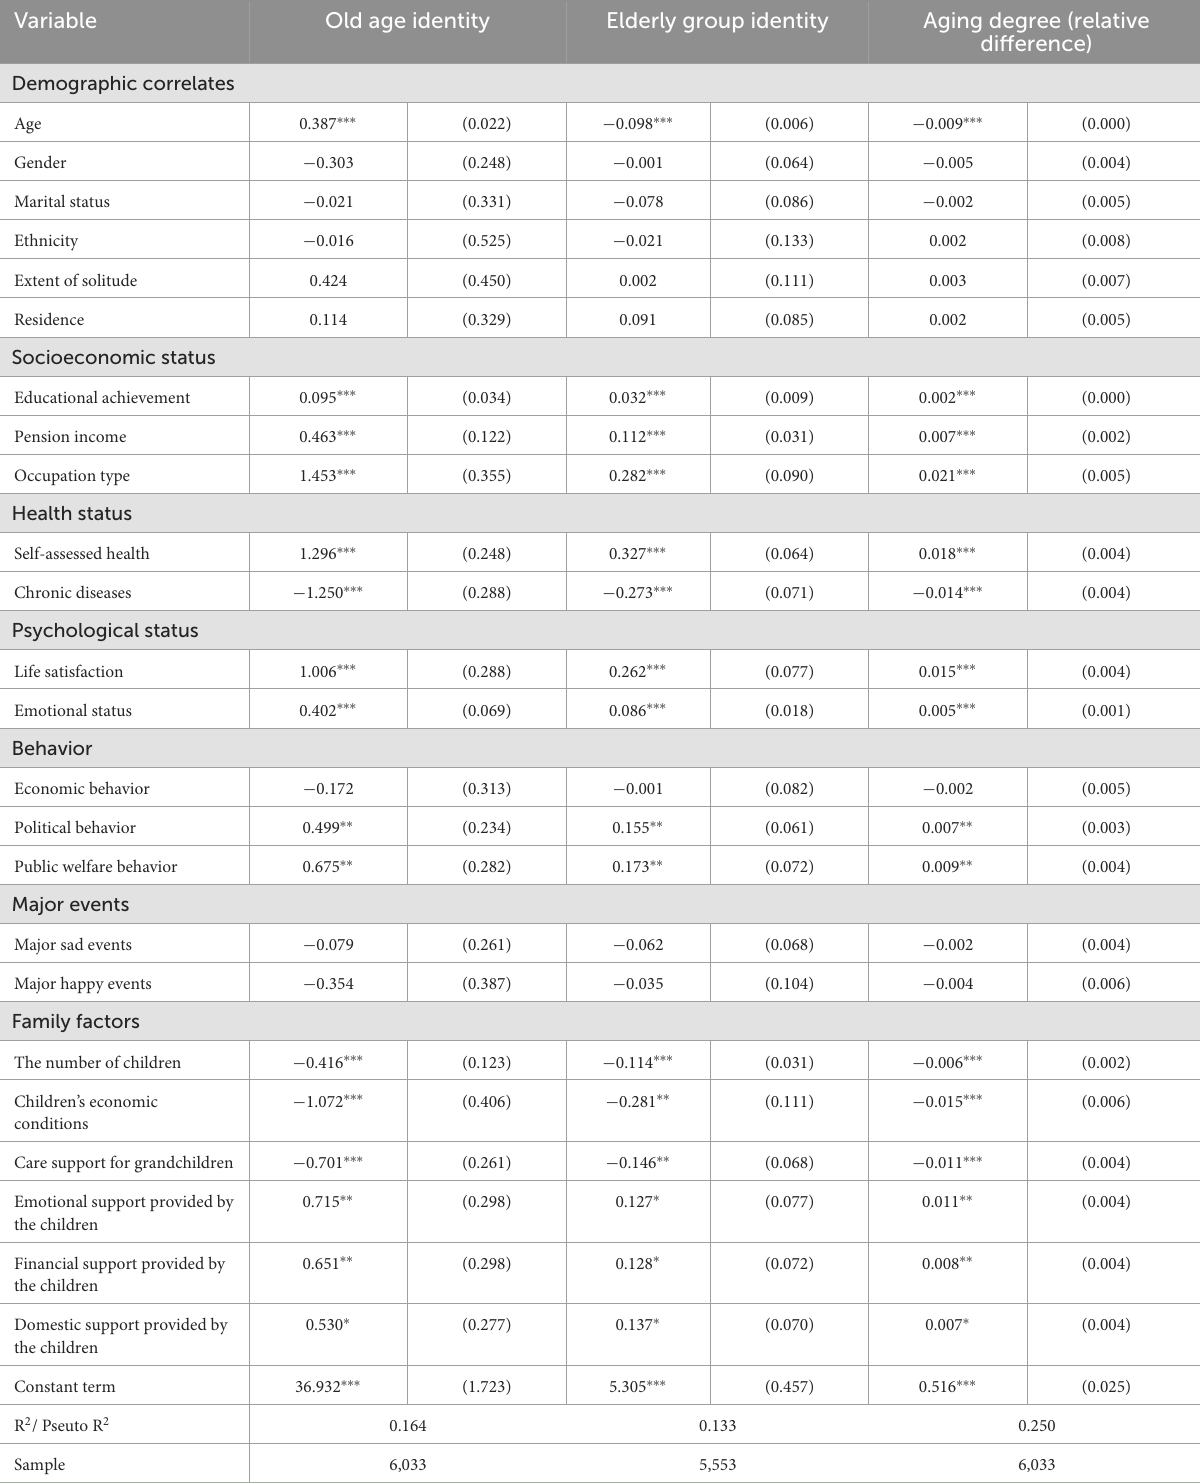
TABLE 3 Empirical results of the factors influencing old age identity among the Chinese elderly.